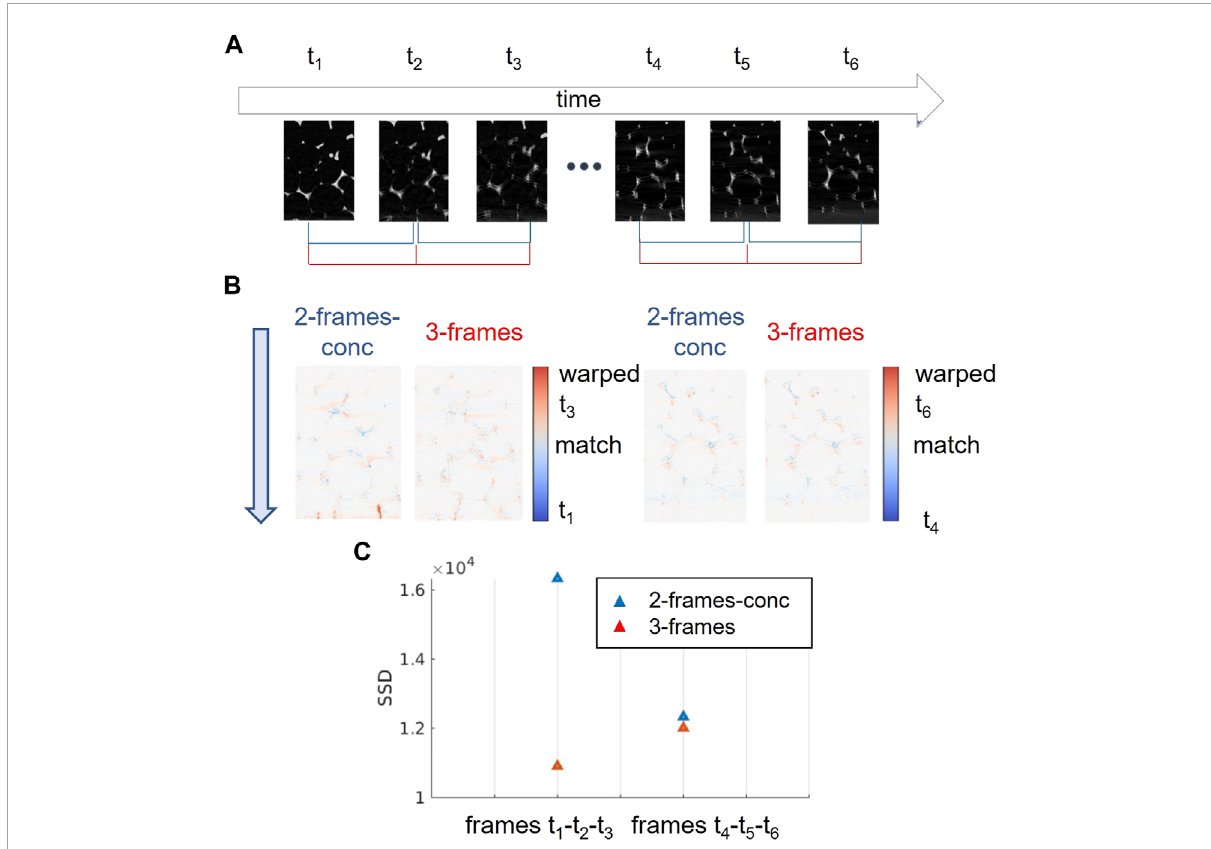
FIGURE 8 (A) Vertical slices of the frames through time. (B) Central slices of the consistency map defined as the difference between the reference and deformed volumes: red regions correspond to material of the warped t 3 / t 6 does not match material in t 1 / t 4 ; blue regions correspond to material of t 1 / t 4 does not match material in the warped t 3 / t 6 ; white regions correspond to material of warped t 3 / t 6 that fully overlap material in t 1 / t 4 . (C) Registration accuracy evaluated by SSD metric for the two